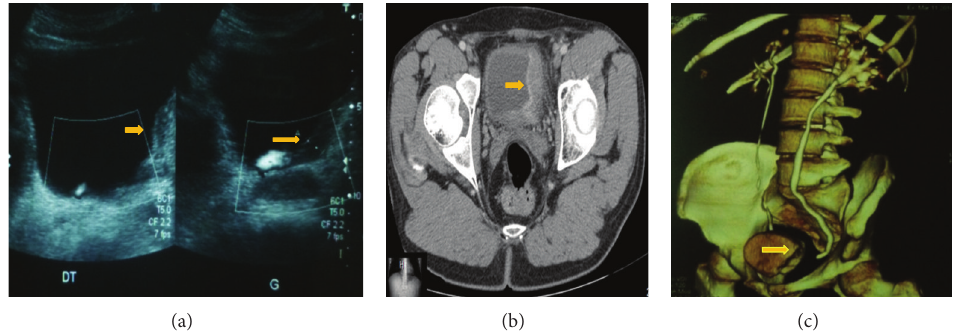
Figure 1: (a) Ultrasound: large mass of the left wall of the urinary bladder. ((b) and (c)) Contrast-enhanced CT scan shows marked and diffuse bladder wall thickening, bladder tumour mainly on the left but extending to the midline anteriorly and beyond the midline posteriorly with moderate dilatation of the upper ureter.